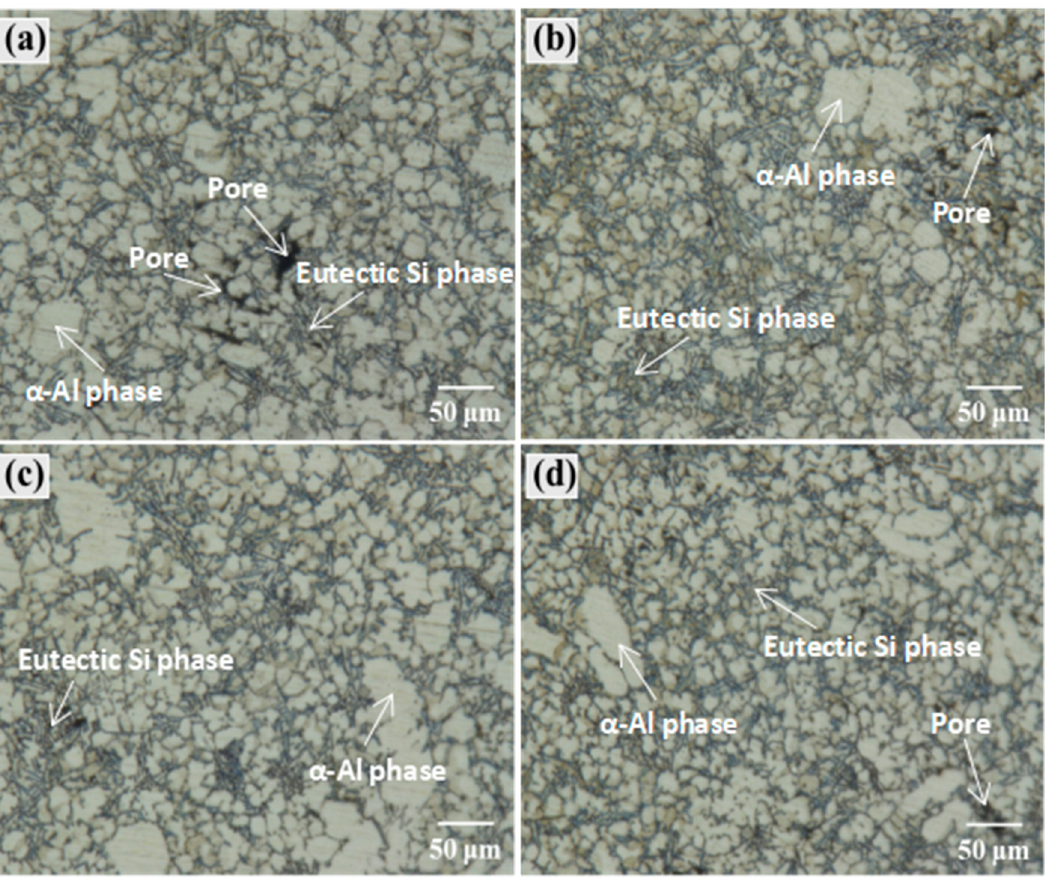
Figure 8. Microstructure of thick-walled area at different injection speeds: ( a ) 3.5 m/s, ( b ) 4.0 m/s, ( c ) 4.5 m/s, ( d ) 5.0 m/s.